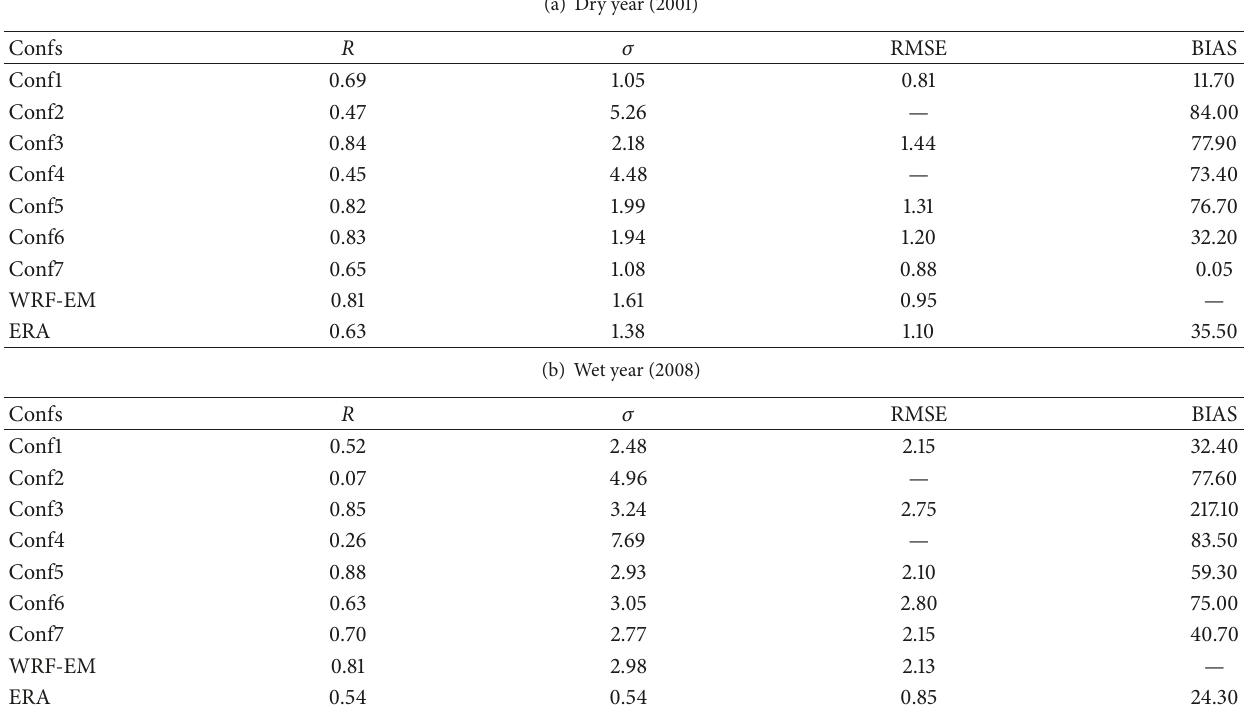
Table 4: The four different statistics, for the coastal zone, for the (a) dry year (2001) and (b) wet year